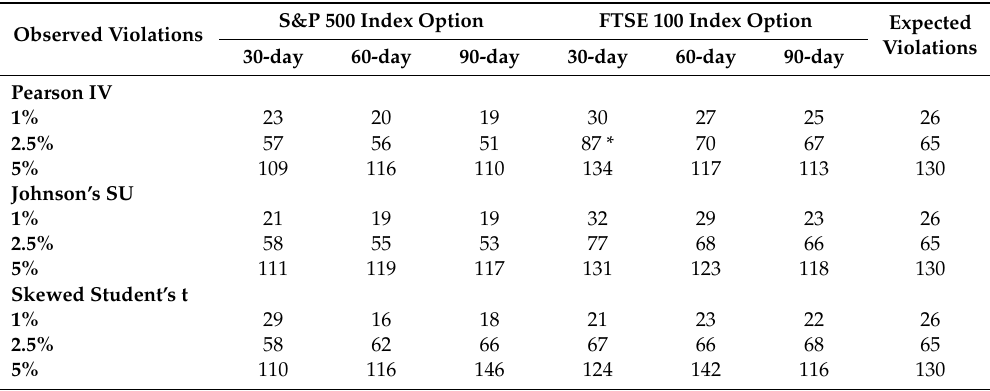
Table 5. Back-testing results for 15-day